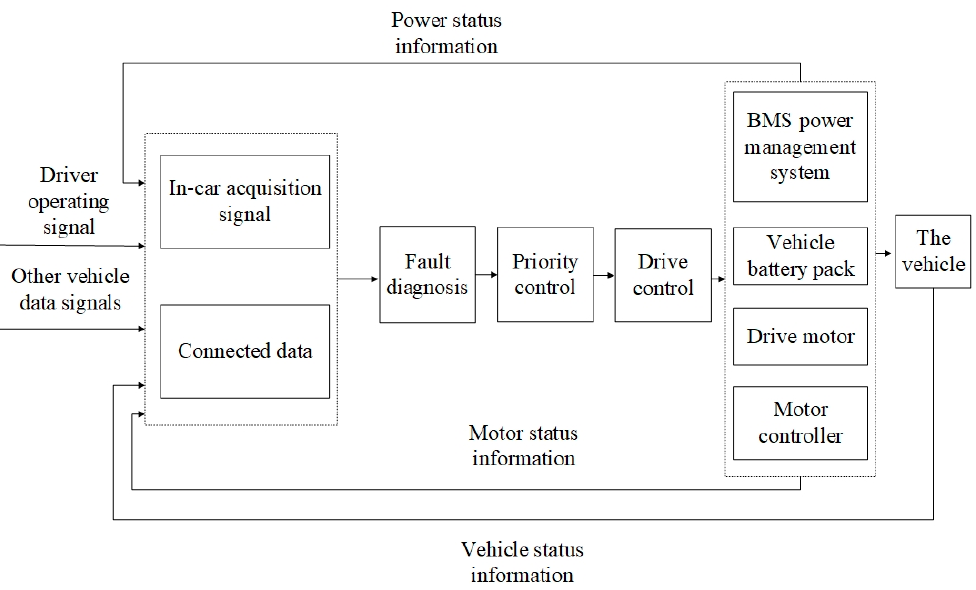
Figure 1. Schematic diagram of the intelligent and connected VCU control strategy